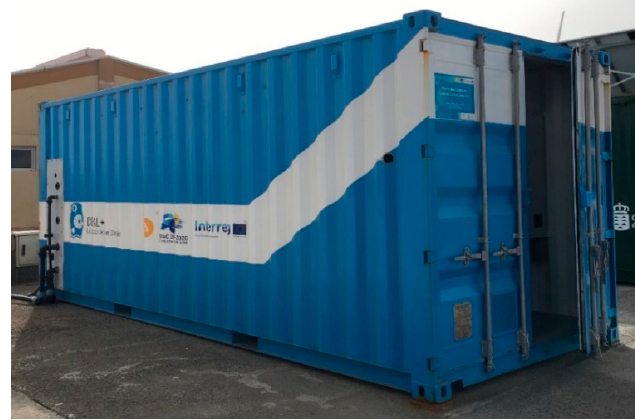
Figure 1. The 20 ft shipping container housing the SWRO desalination plant. Table 1. Main characteristics of the SWRO plant.